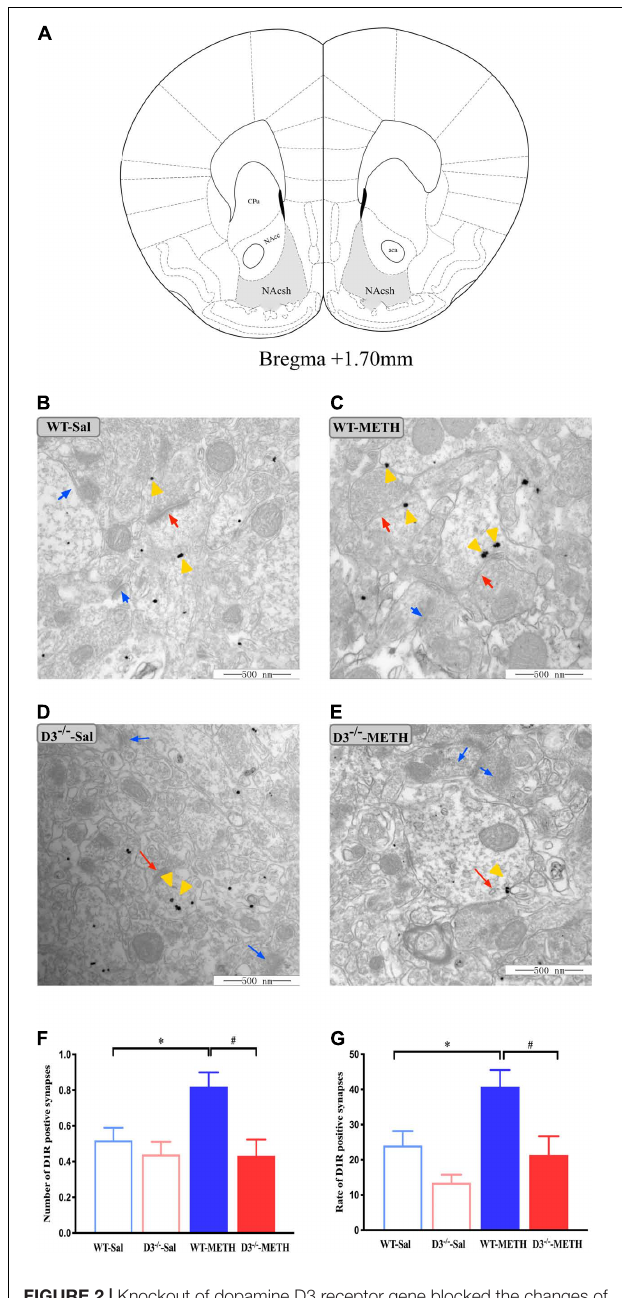
FIGURE 2 | Knockout of dopamine D3 receptor gene blocked the changes of dopamine D1 receptor-positive synapses in the NAcsh of METH-sensitized mice. (A) Nucleus accumbens (NAc) diagram of mice. Coronal brain section representing relative sites of NAcsh (Paxinos et al., 2001) (Gray-shaded area). (B–E) Ultrastructure photos showed synapses in the NAcsh of mice. The red arrows indicated the dopamine D1 receptor-positive synapses, the yellow arrows indicated the silver-intensified gold particles, and the blue arrows indicated the non-positive synapses. Scale bars = 500 µ m. (F–G) Quantification of the number (F) and rate (G) of the dopamine D1 receptor-positive synapses of the four groups of mice ( n = 3 mice each). ∗ P < 0.05 compared with the same genotype in saline group; # P < 0.05 compared with same-dose WT mice. Values are presented as mean ± SEM. NAcc, nucleus accumben core; NAcsh, nucleus accumben shell; aca, anterior commissure; CPu, caudate putamen; WT, wild